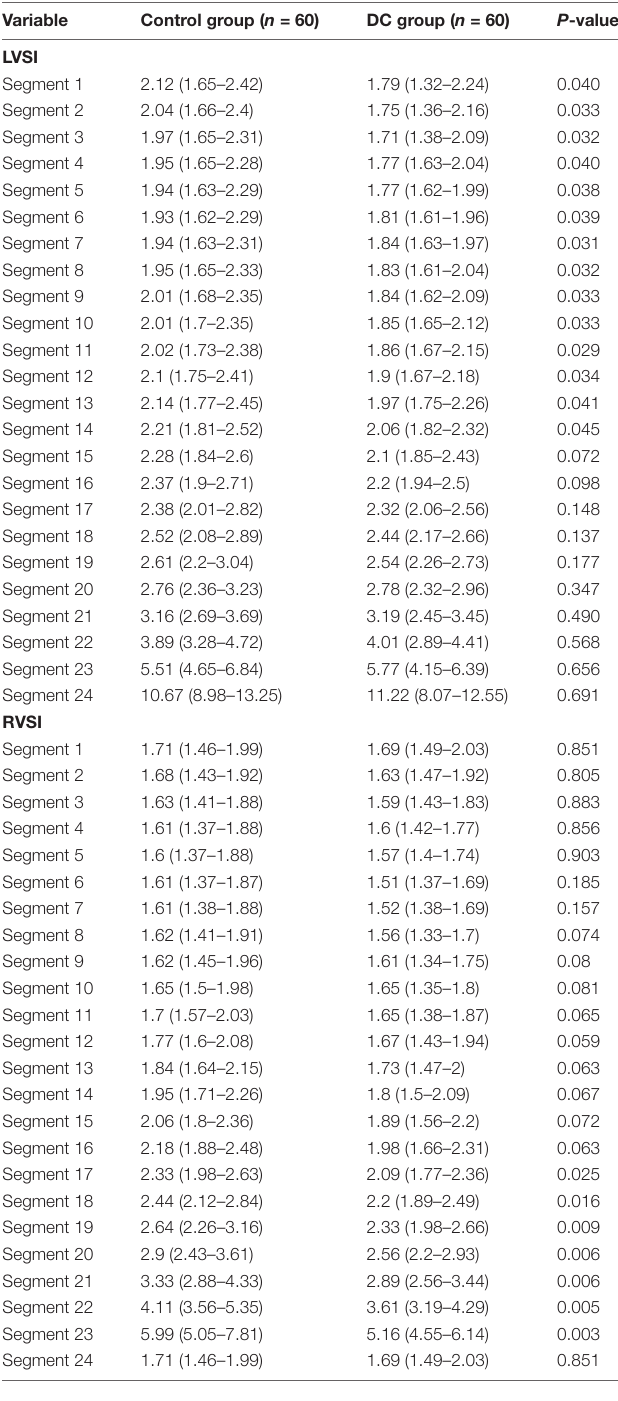
TABLE 5 | Biventricles 24-segments SI in the DA constriction group and the control